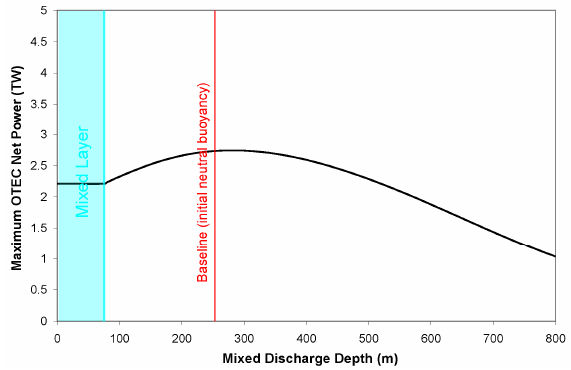
Figure 5. Maximum OTEC net power as a function of mixed-effluent discharge depth for mixed- effluent discharge scenarios; the red line indicates the so-called baseline protocol (initial neutral buoyancy).